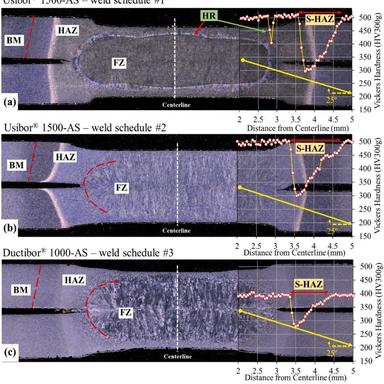
Optical micrograph of the welds and corresponding microhardness profile along the yellow arrow for (a) Usibor® 1500-AS using weld schedule #1, (b) Usibor® 1500-AS using weld schedule #2, and (c) Ductibor® 1000-AS using weld schedule #3. BM: Base metal, HAZ: Heat-affected zone, FZ: Fusion zone, HR: Halo ring, S-HAZ: Softened HAZ. (For interpretation of the references to colour in this figure legend, the reader is referred to the web version of this article.)